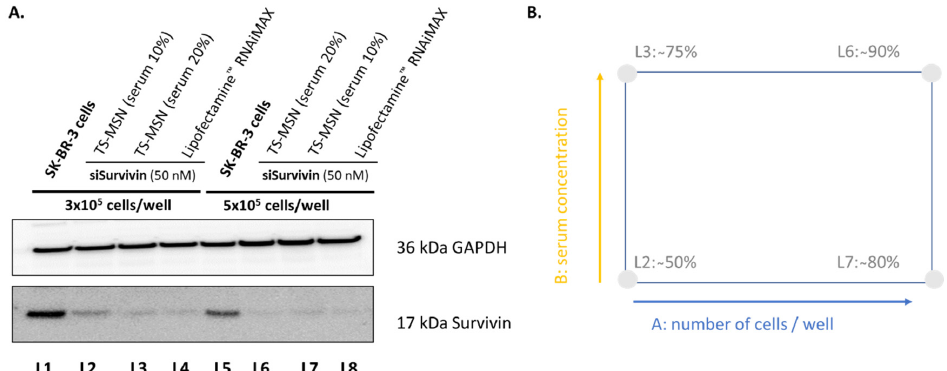
Figure 6. Optimization of the transfection conditions for Western blot experiments using a 2 2 factorial design. ( A ) Western blot result of Survivin protein inhibition. ( B ) Schematic representation of the results to analyze the 2 2 factorial design. Values of Survivin protein inhibition are estimated visually from ( A ). TS-MSN: targeted stealth magnetic siRNA nanovectors, GAPDH: glyceraldehyde 3-phosphate